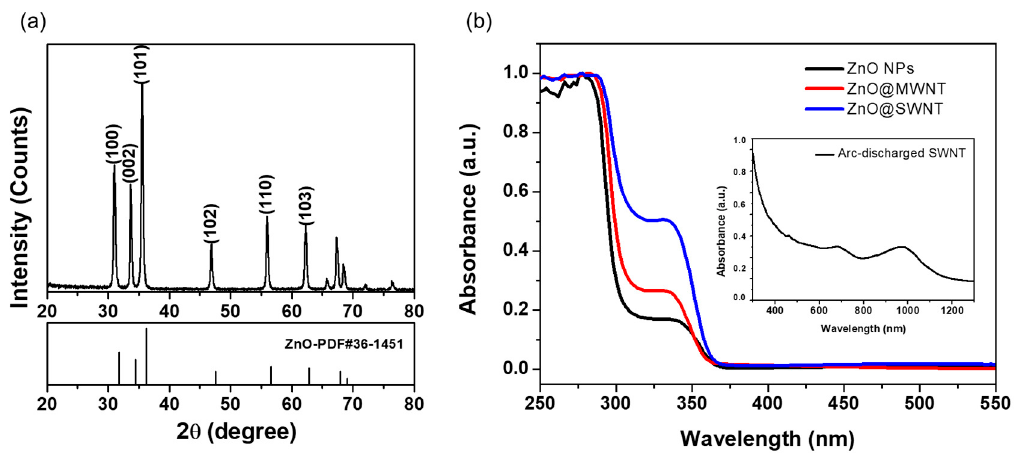
Figure 1. ( a ) XRD patterns of the ZnO NPs and ( b ) UV–Vis absorption spectra of ZnO NPs, ZnO@MWNT, and ZnO@SWNT. Inset shows the UV–Vis absorption spectrum of pure A-SWNT.